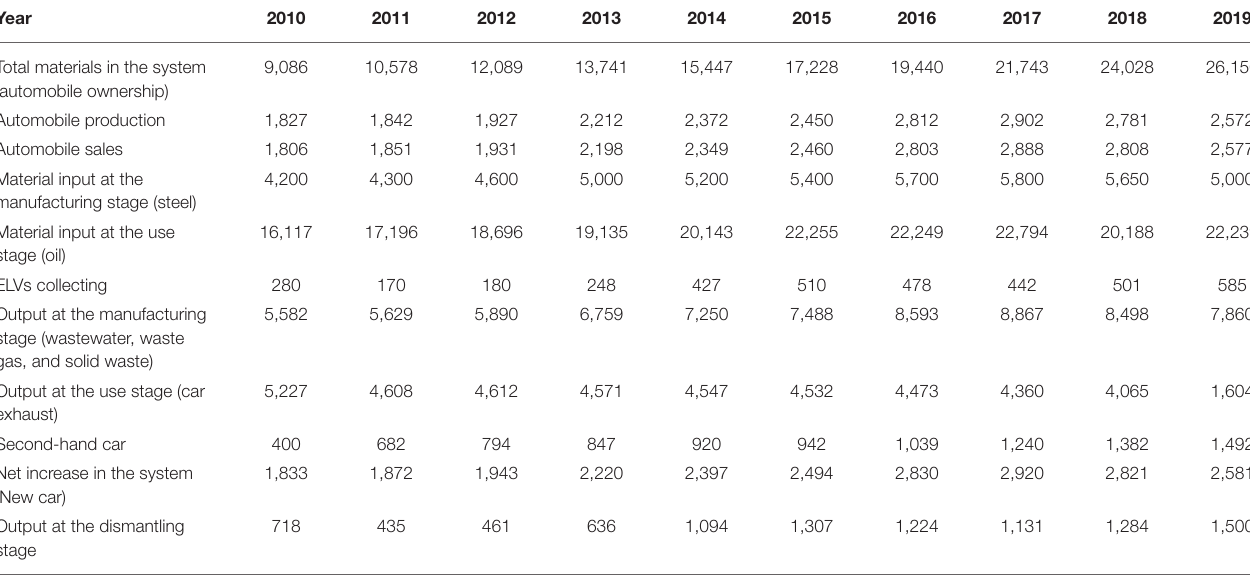
TABLE 1 | Material flow system data of China’ automobile industry